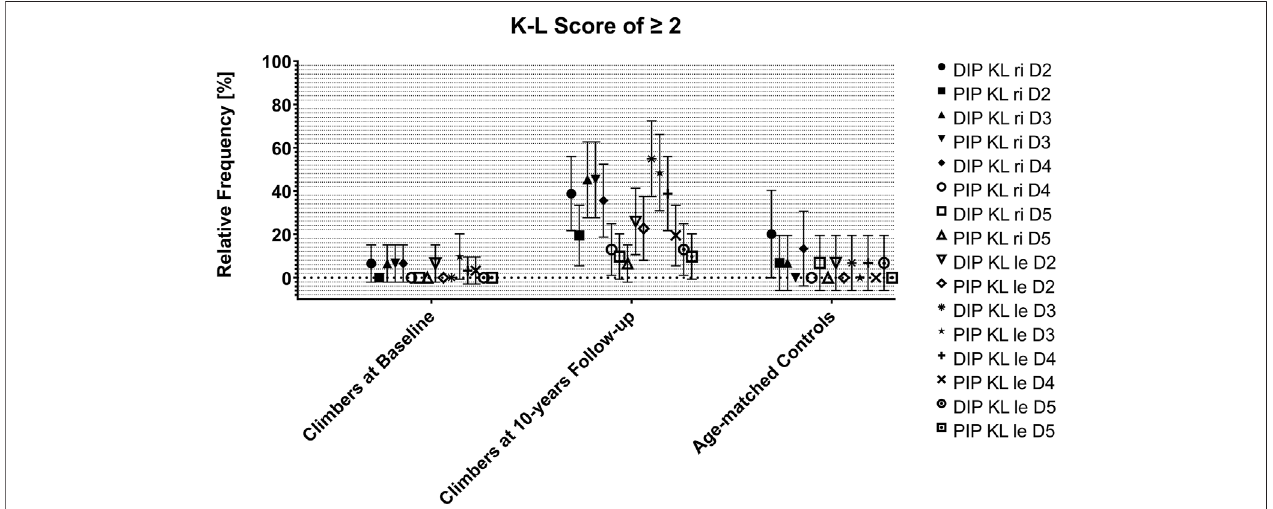
FIGURE 3 | Occurrence of ‘ clear ’ signs of OA (= K-L scores of 2 or higher) in climbers at baseline and at the 10-year follow-up, as well as in their age-matched controls.Dataareexpressedasjoint,sideanddigit-speci fi crelativeproportiongroupmeanswith95%CI.KL:Kellgren-LawrenceScore;DIP:distalinterphalangealjoint; PIP: proximal interphalangeal joint; ri: right; le: left; D: digit.